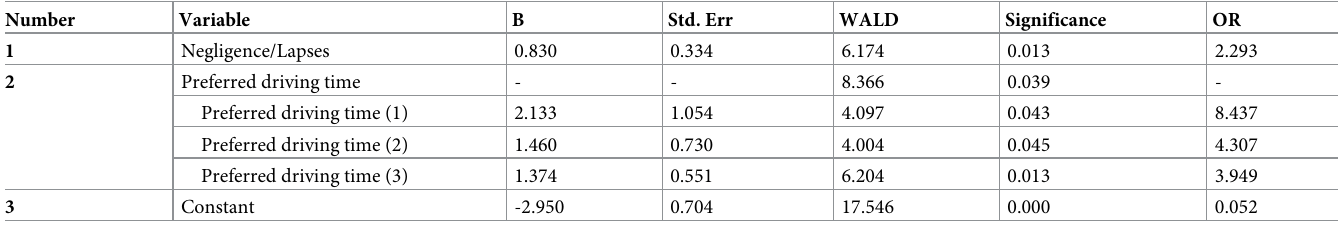
Table 5. Prediction of crashes over previous three